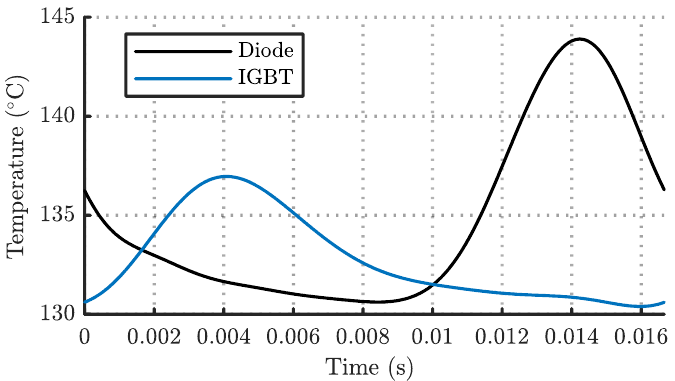
Figure 5. Recovered time-domain diode and IGBT junction temperature for one electric cycle (60 Hz) in a PV inverter [40].